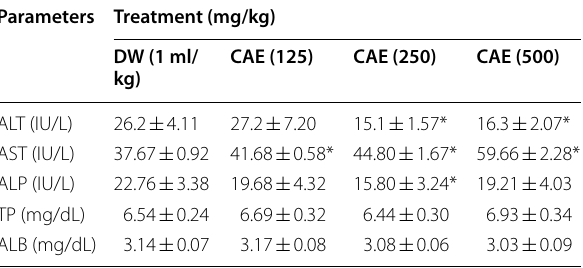
Table 2 Haematological parameters of rats following 28-day repeated administration of Culcasia angolensis leaves extract (CAE)